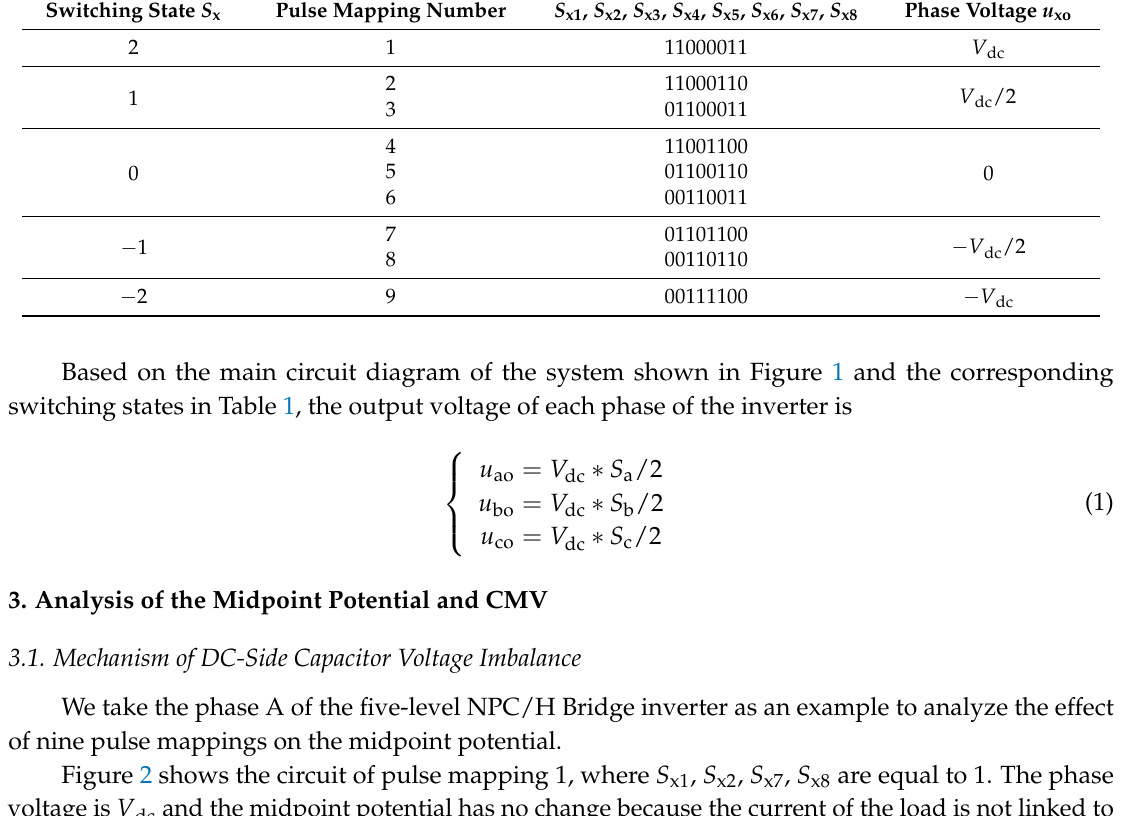
Table 1. The switching states and pulse mappings.